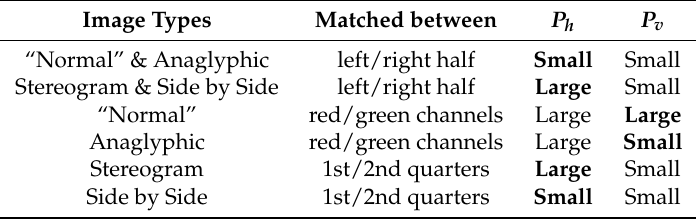
Table 4. Ranges of mean µ h / v and standard deviation σ h / v found on four image types. Image